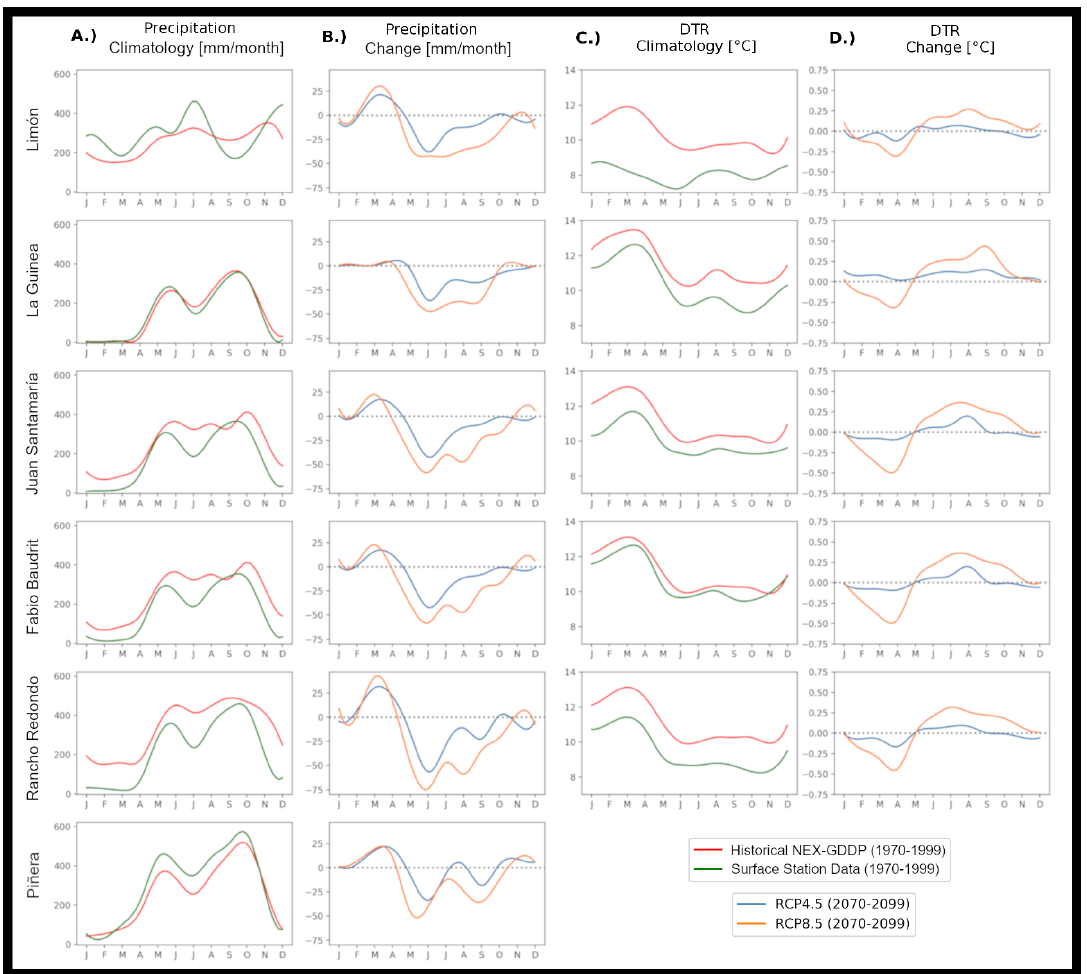
Figure 2. CMIP5 Monthly Multimodel Ensemble distributions for historical NEX-GDDP precipitation and diurnal temperature range (DTR) for the period 1970–1999 as compared to different surface station data (column ( A ) and ( C ), respectively), and their corresponding future changes for the period 2070–2099 for RCP 4.5 and 8.5 scenarios (column ( B ) and ( D ), respectively). See Figure 1 for station data location.